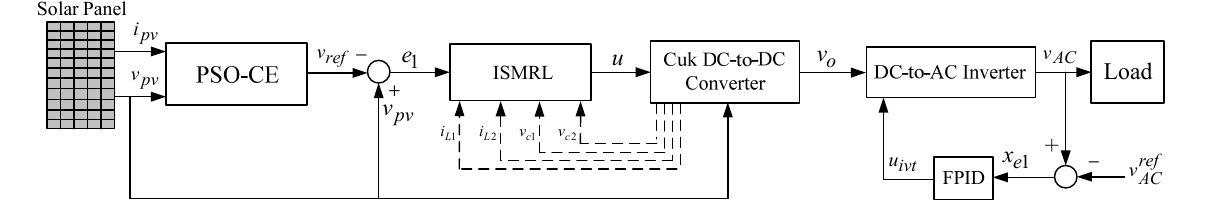
Figure 3. Block diagram of total control system.